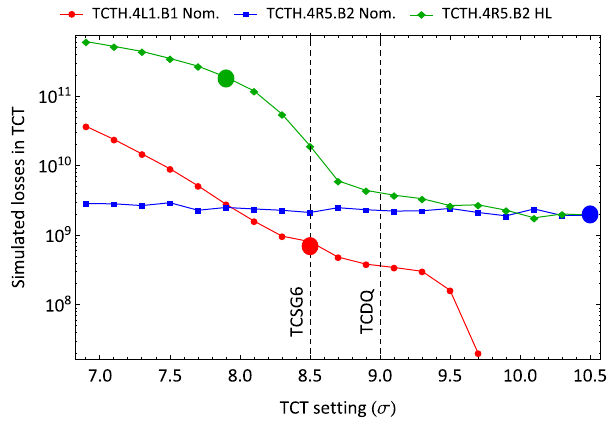
FIG. 5. Losses at TCTs as a function of collimator retraction for different beam optics. Each colored line refers to the most impacted TCT in the three simulated cases. The bigger markers are the scenarios selected for the study.